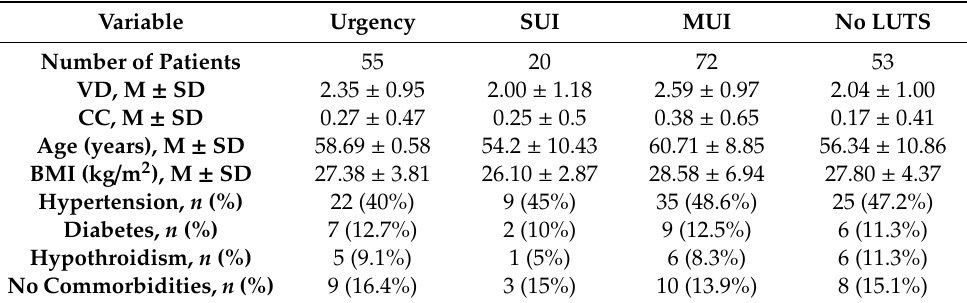
Table 1. Patient demographic